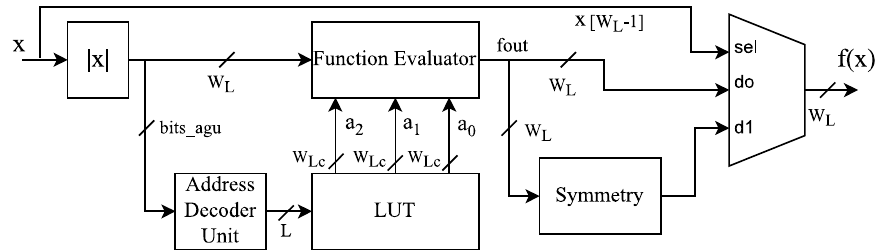
Figure 3. Proposed hardware architecture for implementing the AFC.